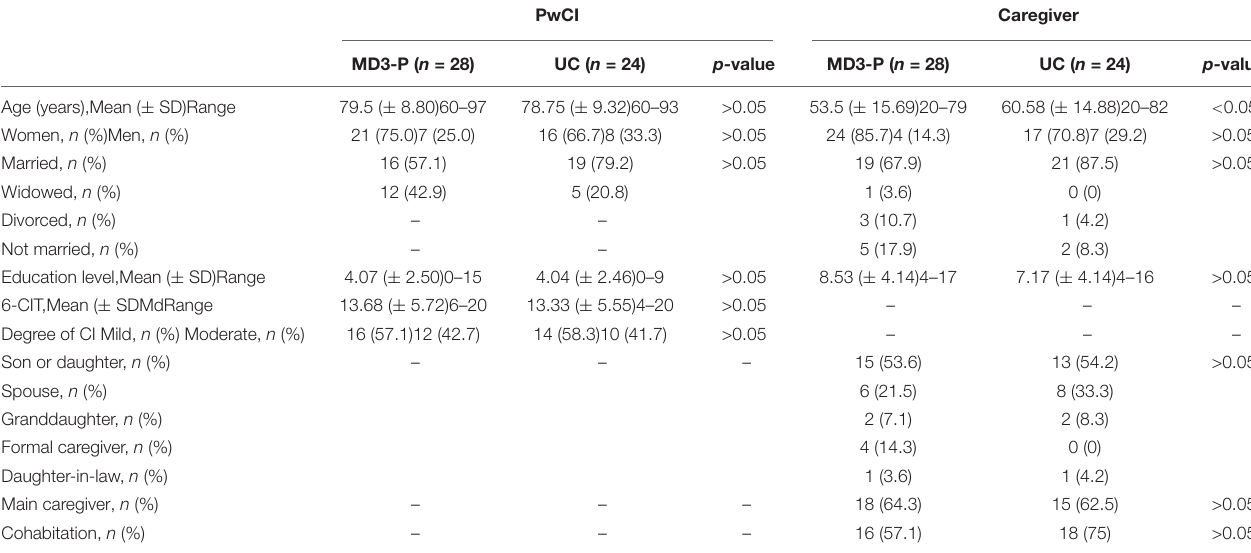
TABLE 3 | Sociodemographic characteristics of PwCI and caregiver.